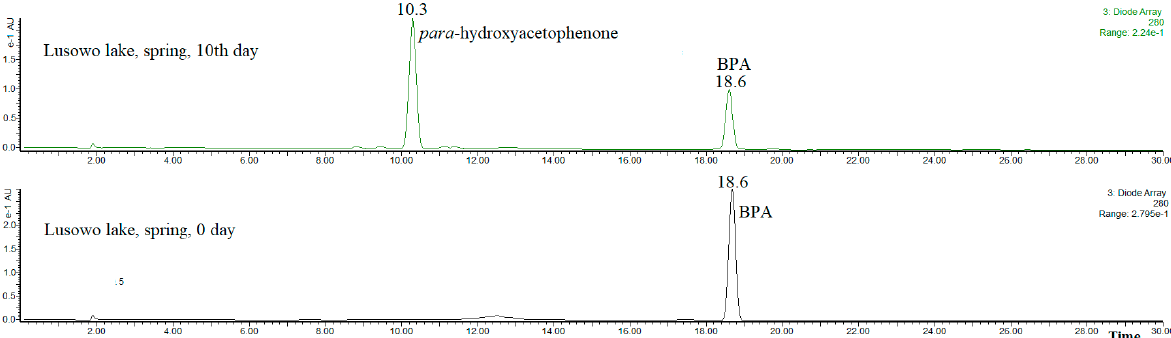
Figure 5. Exemplary UV chromatograms obtained at 280 nm (non-acidified gradient).